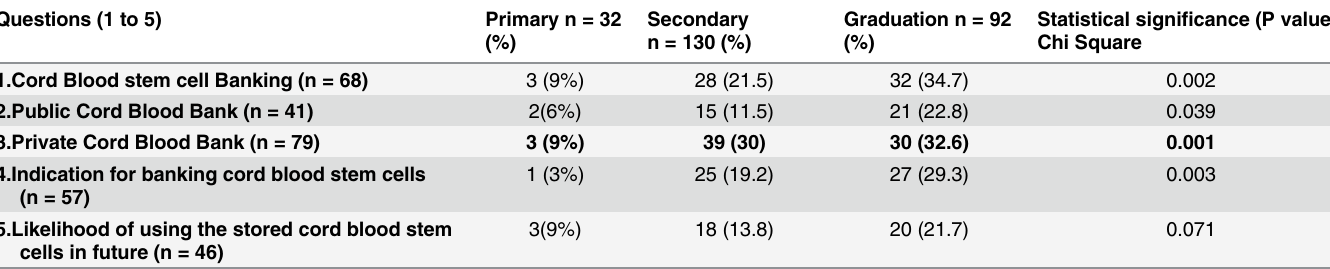
Table 3. Relationship between awareness levels and educational status.